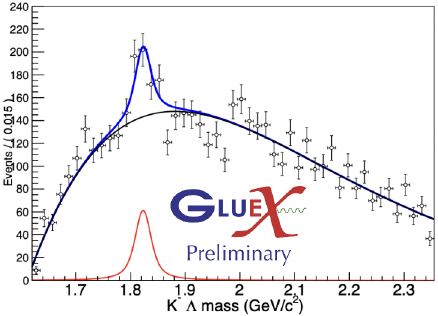
Figure 10. Preliminary invariant mass spectrum of the K − Λ subsystem in the reaction γ p → K + K + Ξ ∗− → K + K + K − Λ → K + K + K − π − p for E γ = 7 . 4GeV to 8 . 0GeV. The Ξ ∗− (1820) can be identified as a peak on some background dis-